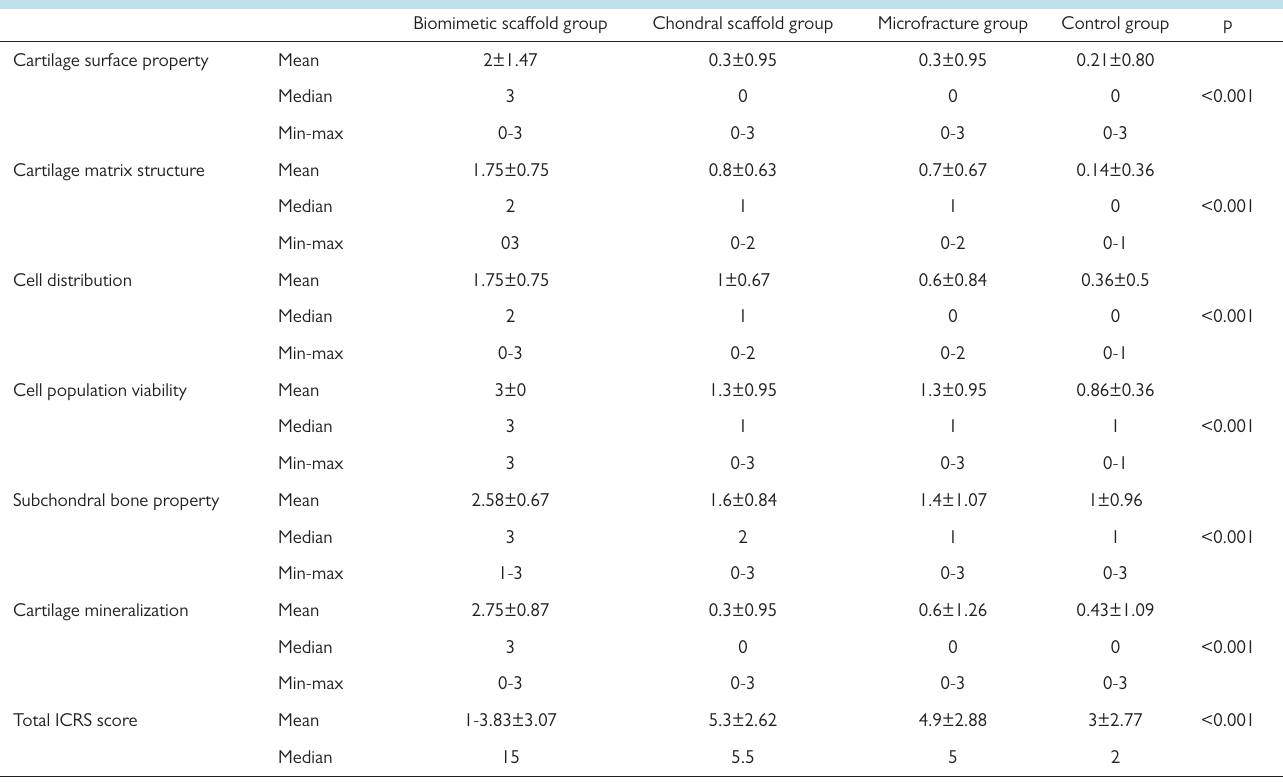
Table 6. Mean, median, and (minimum and maximum) values of the ICRS